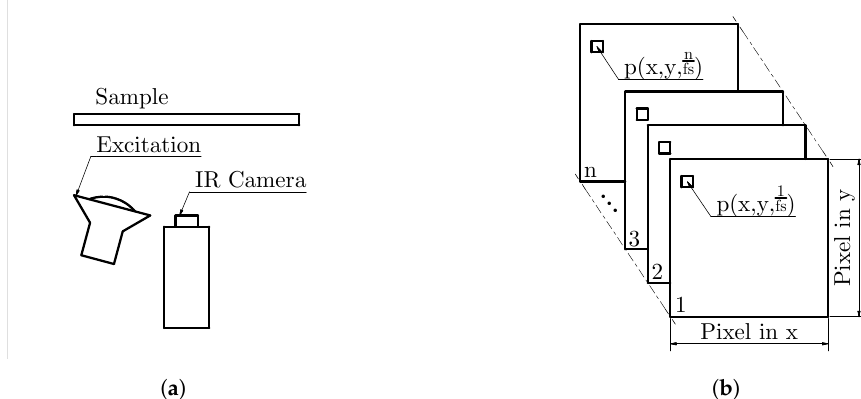
Figure 1. Pulsed thermography experiment: ( a ) measurement setup in reflection and the ( b ) data format of a thermographic